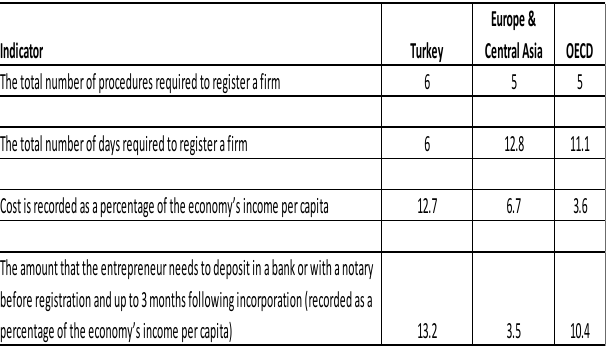
Table 1. Turkey’s Ratings for Starting a Business